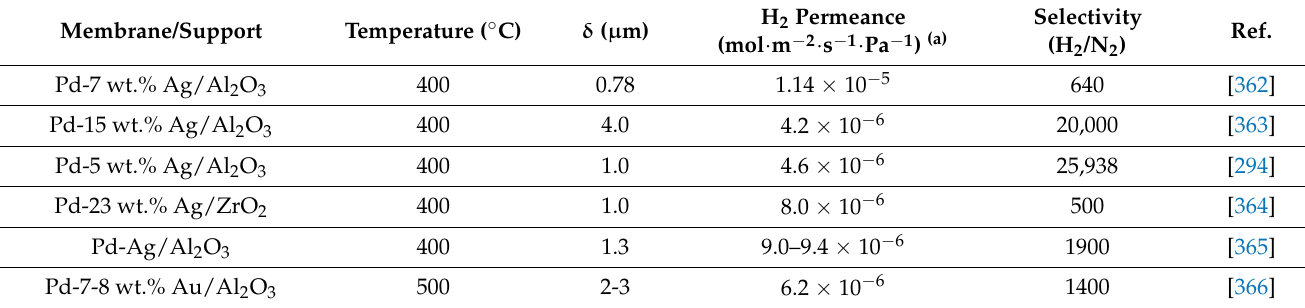
Table 8. Summary of Pd-based thin membranes’ performances and respective characteristics (H 2 diffusion through the membrane does not control the permeation